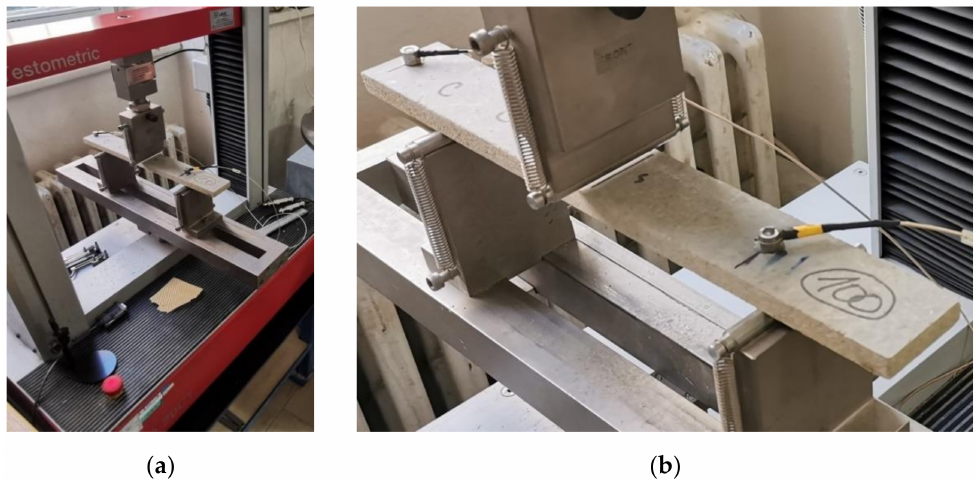
Figure 9. The scheme of arrangement for establishing the bending strength and elasticity modulus with continual monitoring and recording of acoustic emissions: ( a ) testing arrangement; ( b ) a detail of the tested specimen with placed exciter and acoustic signal